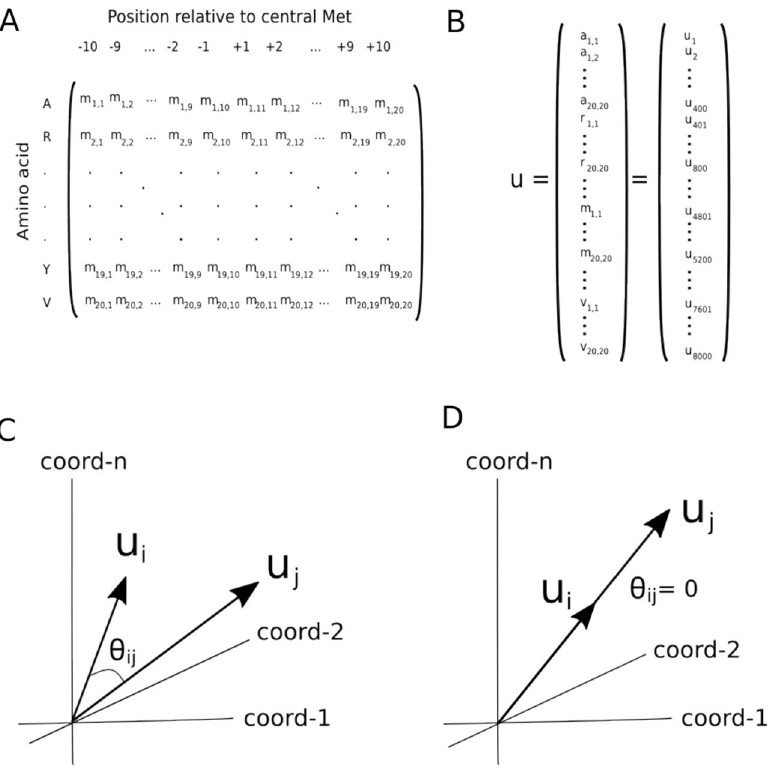
Figure 1. Encoding species as vectors. ( A ) For the sake of concreteness, we will focus on the sequence environment around methionine residues using a radius of 10 residues. Thus, a given proteome can be number of arginines found 9 residues away (toward the N-terminal) from any methionine residue. ( B ) Now, considering not just methionine but the 20 proteinogenic amino acids, the protein-coding genome of a given species of interest can be characterized by a set of 20 square matrices of order 20 or, equivalently, by a vector, u ∈ U 8000 , of dimension 8000. It should be noted that, when coding species as vectors, the dimension of